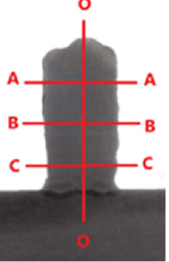
Figure 4. ( a ) Bo tt om view of baseplate and locations for measurement of residual stresses; ( b ) Setup for the residual stress measurement.